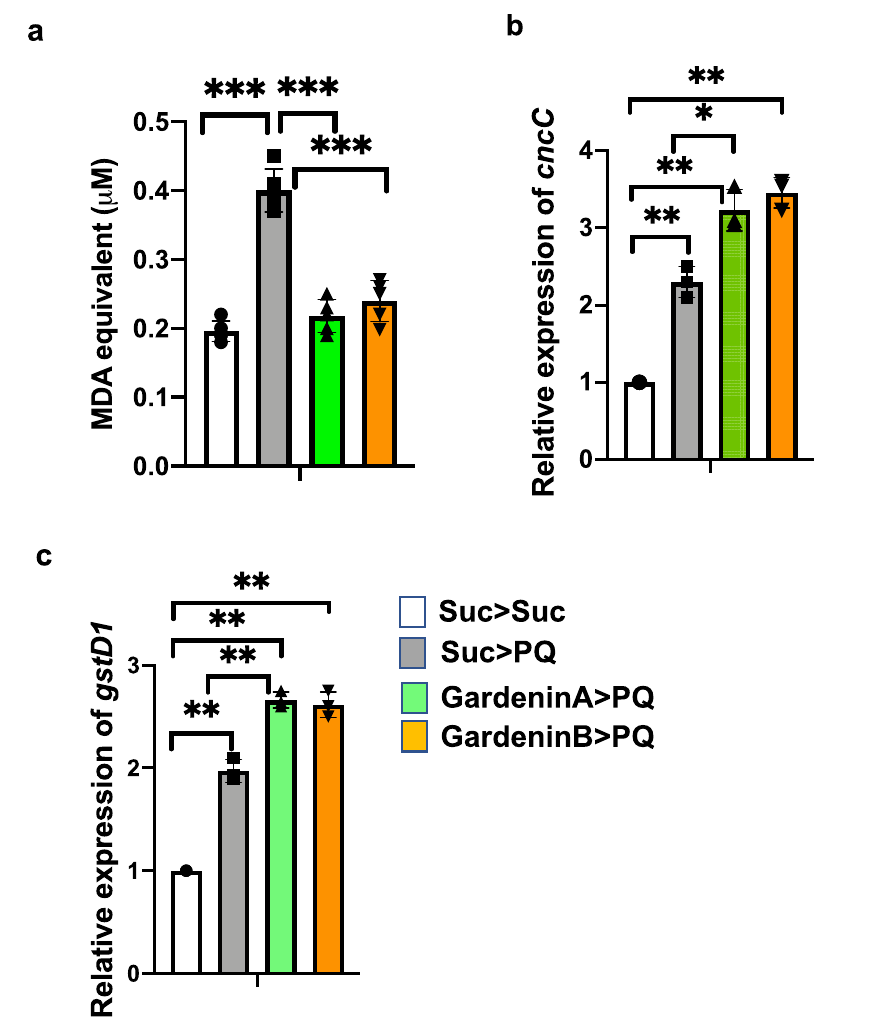
Fig. 3 The neuroprotective effect of GardeninA against PQ toxicity is not dependent on its antioxidant activities. a Effects of GA and GB on the levels of MDA as a marker for lipid peroxidation due to oxidative stress using a fl uorometric assay. Adult male fl ies were either pre-fed for 4 days with 2.5% sucrose or GA or GB (10 μ M) followed by exposure to sucrose or 5 mM PQ for 18 h (white bar: Suc>Suc, gray bar: Suc>PQ, green bar: GardeninA>PQ, orange bar: GardeninB>PQ). The fl y head homogenates were used to detect the levels of MDA ( μ M) based on the calibration curve generated using the standards provided with the fl uorometric kit. All experiments were performed in triplicate and represent at least three independent biological repeats. Data shown represent mean ± SEM. *** p < 0.001 based on one-way ANOVA between different feeding conditions. b , c Effects of GA and GB on the transcript levels of cncC , the human Nrf2 orthologue in Drosophila and the downstream oxidative stress response gene, gstD1 using qRT-PCR. RNA was isolated from the heads of adult fl ies following exposure to the indicated feeding conditions. The transcript levels of cncC and gstD1 were analyzed and plotted after normalization with rp49 levels as the internal control. Each data point represents mean ± SEM. The mRNA fold changes are normalized to the sucrose-fed (Suc > Suc) fl ies (assigned a value of 1). ** p < 0.01 between different feeding conditions based on the Mann – Whitney U